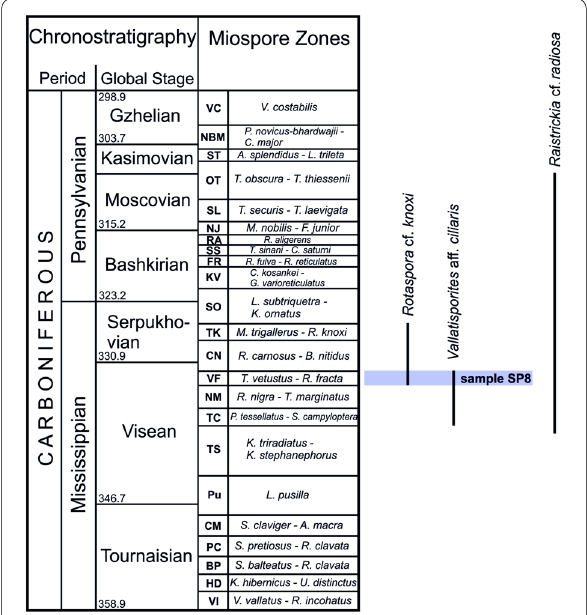
Fig. 7 Zonal scheme and general ranges of selected miospore taxa recovered from the samples. The Carboniferous miospore zonation according to Clayton et al. (1977) and Owens et al.